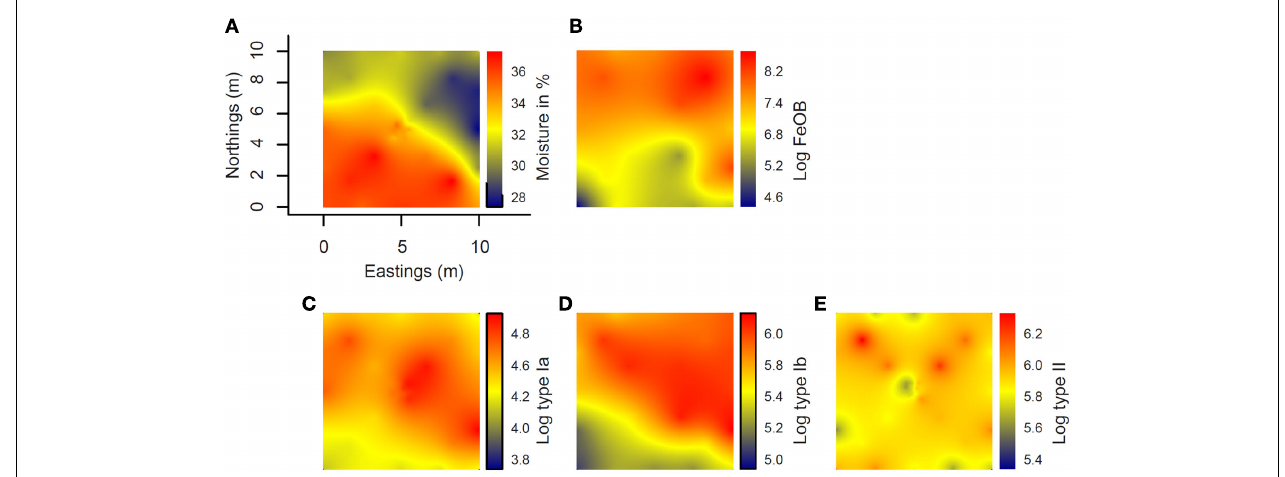
FIGURE 7 | Spatial interpolation maps (kriging maps) of the distribution at the study site of moisture content (A) and log-transformed gene copy